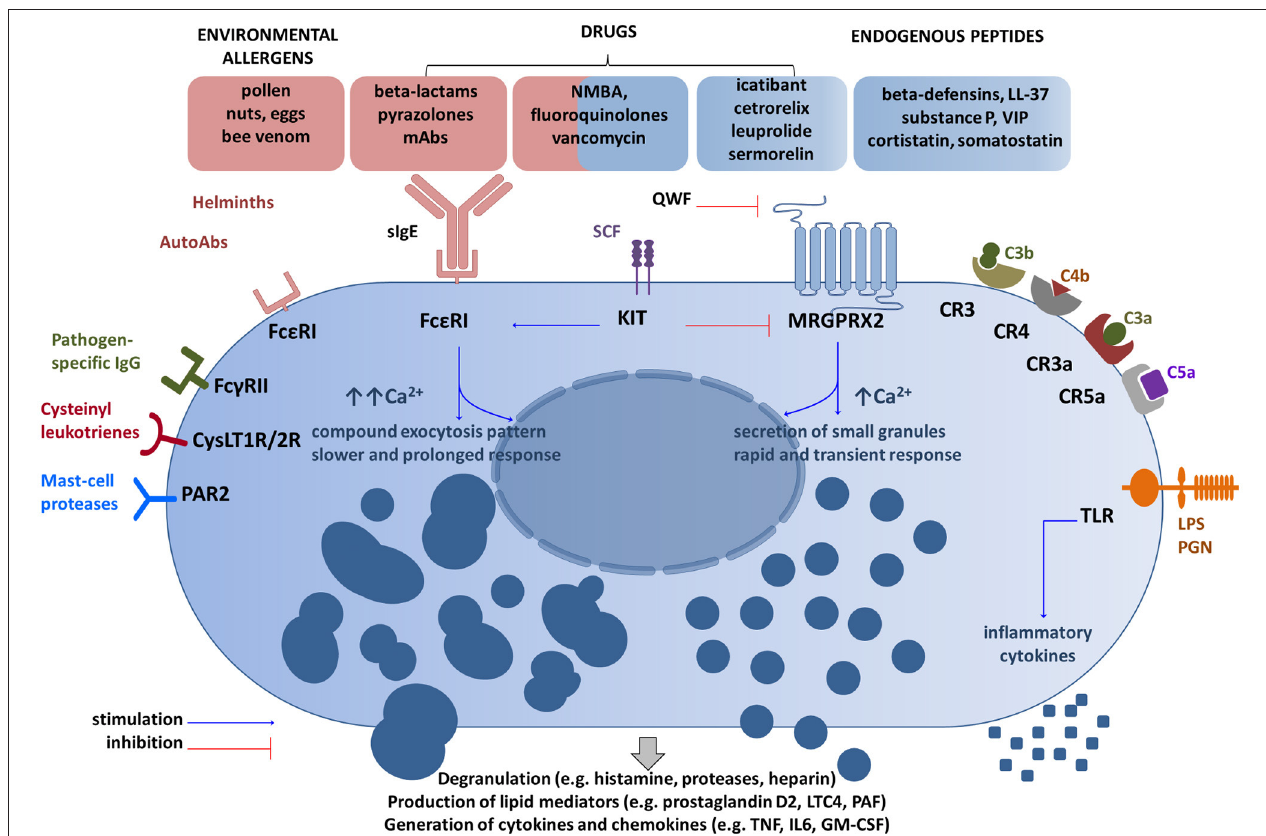
FIGURE 1 | Main receptor systems and examples of ligands involved in mast cell activation. Drugs can activate mast cells through both sIgE-dependent mechanism and the MRGPRX2 receptor (14, 26, 38). These activation routes are independent and inversely regulated by SCF (51). QWF inhibits activation of human MRGPRX2 by a number of basic secretagogues and medications ( 47, 50, 52), but not by LL-37 (53). Granule processing and response program after the MRGPRX2 engagement differ from Fc ε RI-mediated response ( 32, 33). Several other representative MC receptor systems and ligands are shown (28, 29).CR, complement receptor for corresponding complement components; CysLT1R/2R receptors, cysteinyl leukotrienes; Fc γ RII, a low-affinity receptor for IgG; Fc ε RI, the high affinity IgE receptor; GM-CSF, granulocyte/macrophage colony-stimulating factor; IL, interleukin; KIT, mast/stem cell growth factor receptor (CD117); LPS, lipopolysaccharide; LTC4, leukotriene C4; Abs, antibodies; MRGPRX2, Mas-Related G Protein-Coupled Receptor-X2; NMBA, neuromuscular blocking agents; PAR2, protease-activated receptor 2; PGN, peptidoglycan; SCF, stem cell factor; sIgE, specific IgE; TLR, Toll-like receptor; TNF, tumor-necrosis factor; QWF–tripeptide (the glutaminyl-D-tryptophylphenylalanine); VIP, vasoactive intestinal peptide. The schematic drawings were generated by modifying images obtained from Motifolio (Motifolio Inc., Elliocott City, MD,